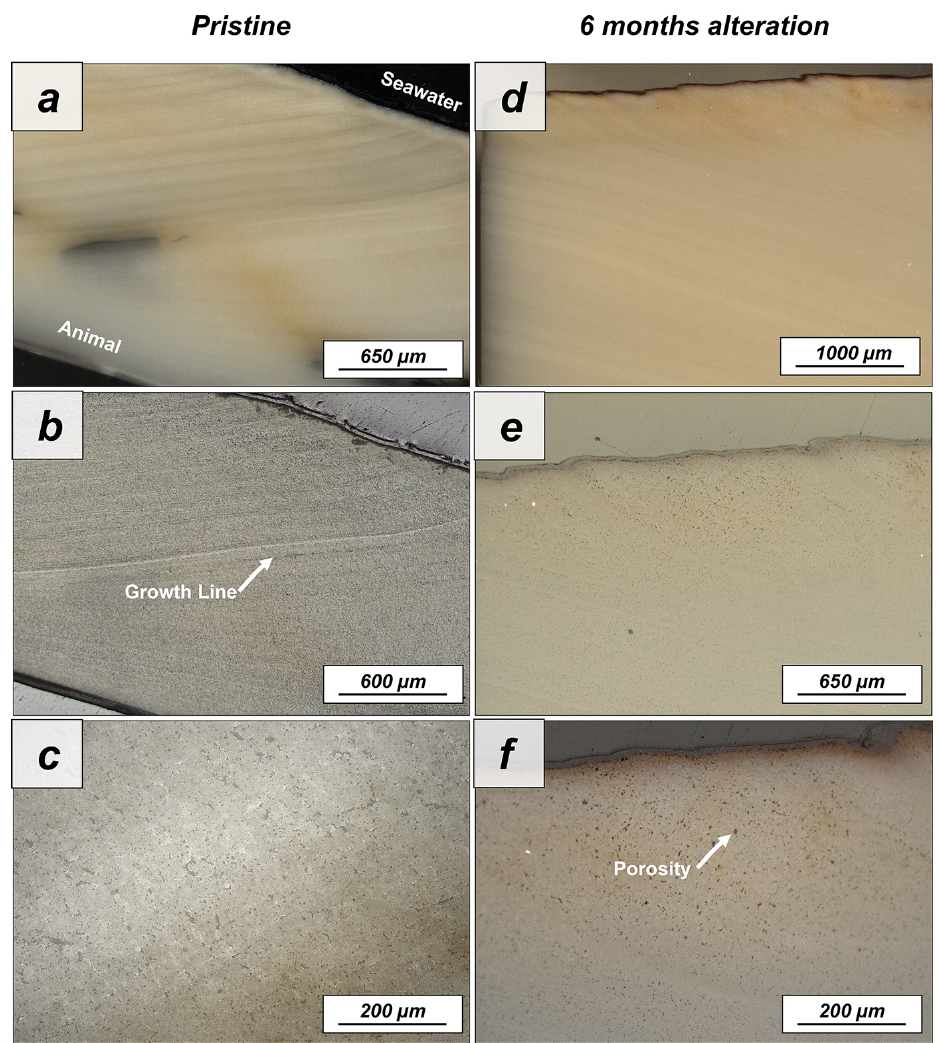
Figure A4. Laser confocal microscopy images of (a–c) pristine and (d–f) altered shells of Arctica islandica . The shells display a homoge- neous internal structure where porosity and growth lines can be observed. After 6 months of hydrothermal alteration, major changes to the shell structure cannot be observed with laser confocal microscopy